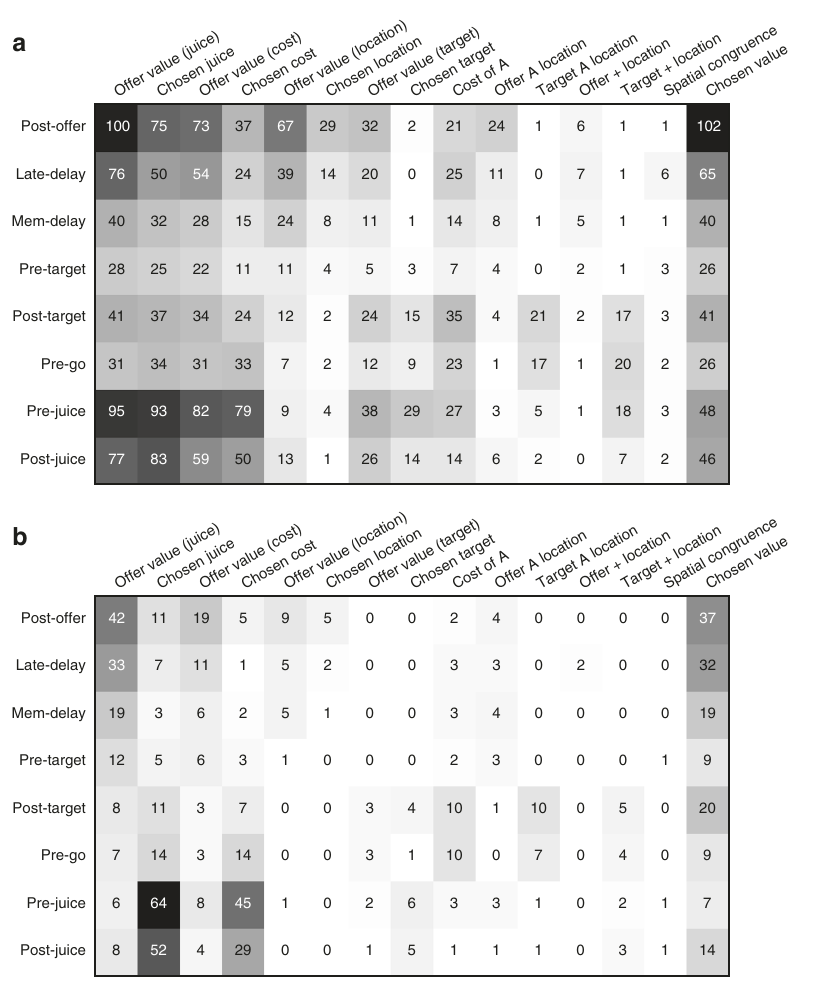
Fig. 4 Population summary of linear regressions (all time windows). a Explained responses. Row and columns represent time windows and variables, respectively. In each location, the number indicates the number of responses explained by the corresponding variable in that time window. For example, in the post-offer time window, the variable offer value (juice) explained 100 responses. The same numbers are also represented in gray scale. Note that each response could be explained by more than one variable and thus could contribute to multiple bins in this panel. b Best fi t. In each location, the number indicates the number of responses for which the corresponding variable provided the best fi t (highest R 2 ). For example, in the post-offer time window, the variable offer value (juice) provided the best fi t for 42 responses. The numerical values are also represented in gray scale. In this plot, each response contributes to at most one bin. Qualitatively, offer value (juice) , and chosen value seem to be the dominant variables in early time windows. Conversely, chosen juice and chosen cost seem to be the dominant variables in late time windows. The variable chosen value is present througout the